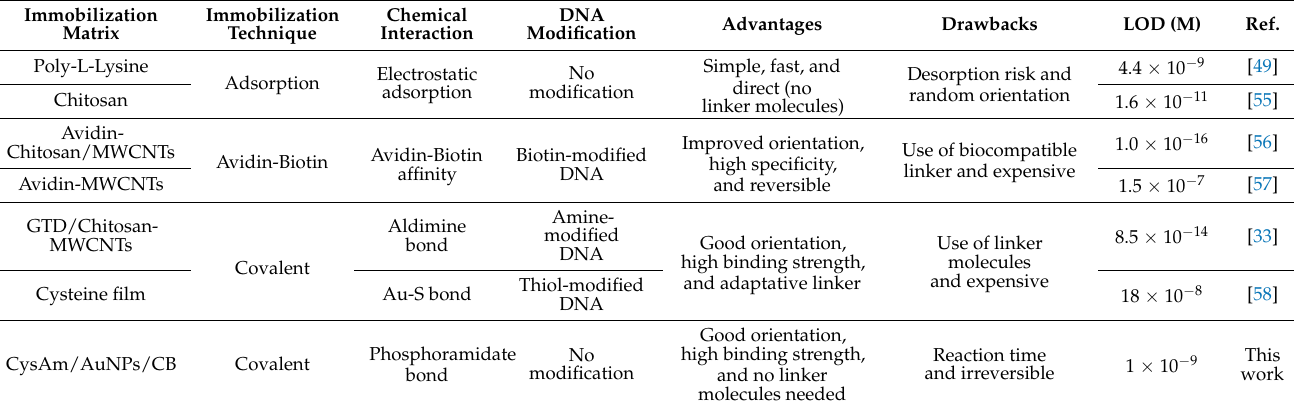
Table 1. Comparison of different strategies of ssDNA probe immobilization on different matrix.